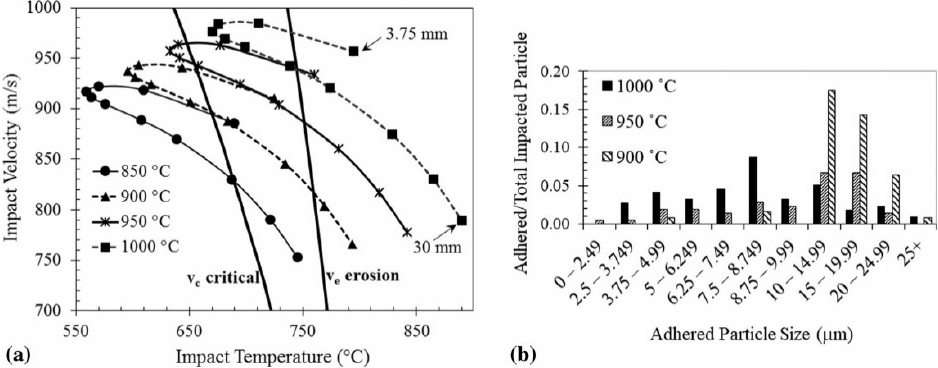
Figure 17. ( a ) Empirically derived SAM1651 amorphous alloy coating deposition window, bounded by V c and V e , with T s = 1.4 T g , ( b ) the particle size ratios of different sizes were measured experimentally at 900, 950, and 1000 °C Reprint from [74] Copyright 2021 Springer